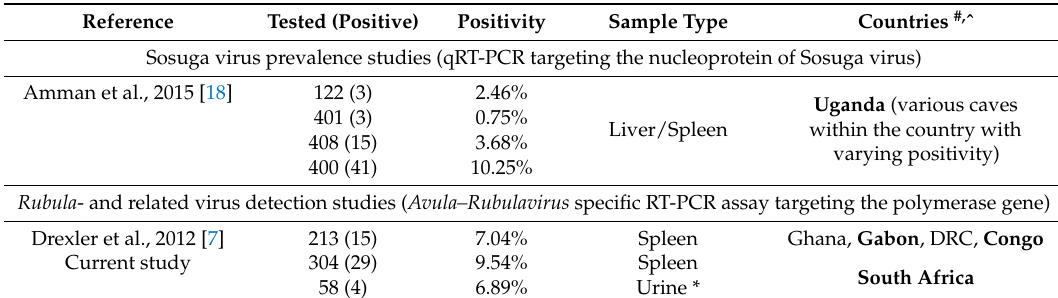
Table 3. A summary of paramyxovirus detection through molecular detection studies and percentage positivity in Rousettus aegyptiacus